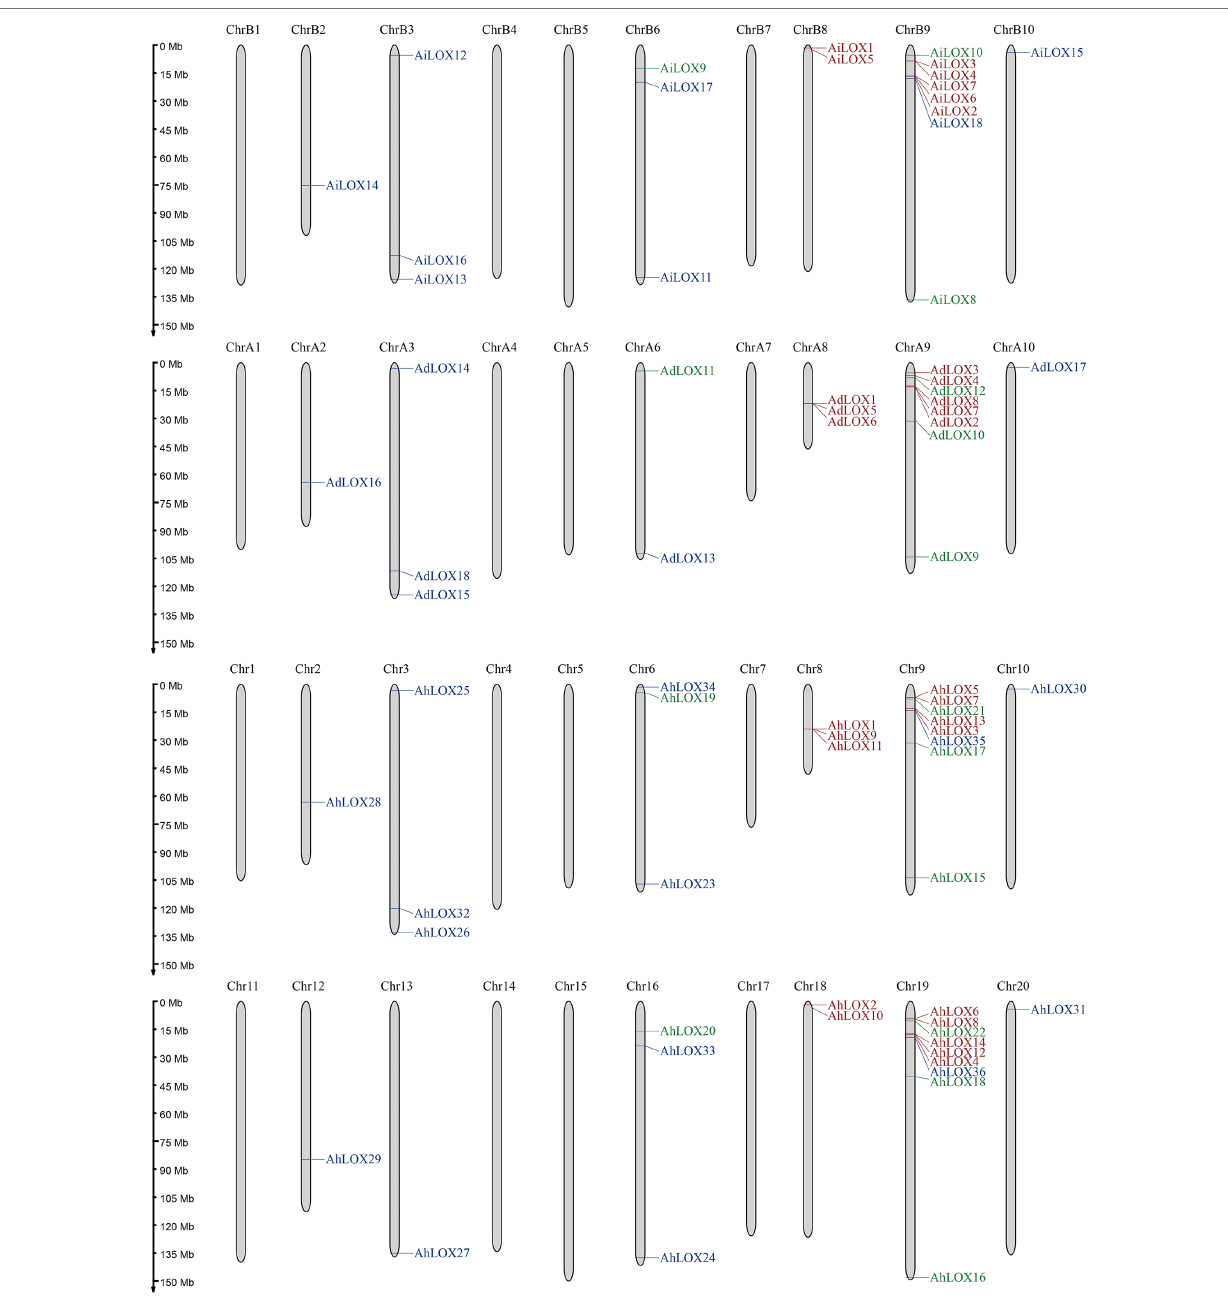
FIGURE 5 | Chromosomal locations of LOX genes. The approximate locations of the 72 peanut LOX genes are displayed on the right side of the chromosomes. Genes from different subfamilies are shown in different colors (9-LOX: green, type I 13-LOX: red, and type II 13-LOX: